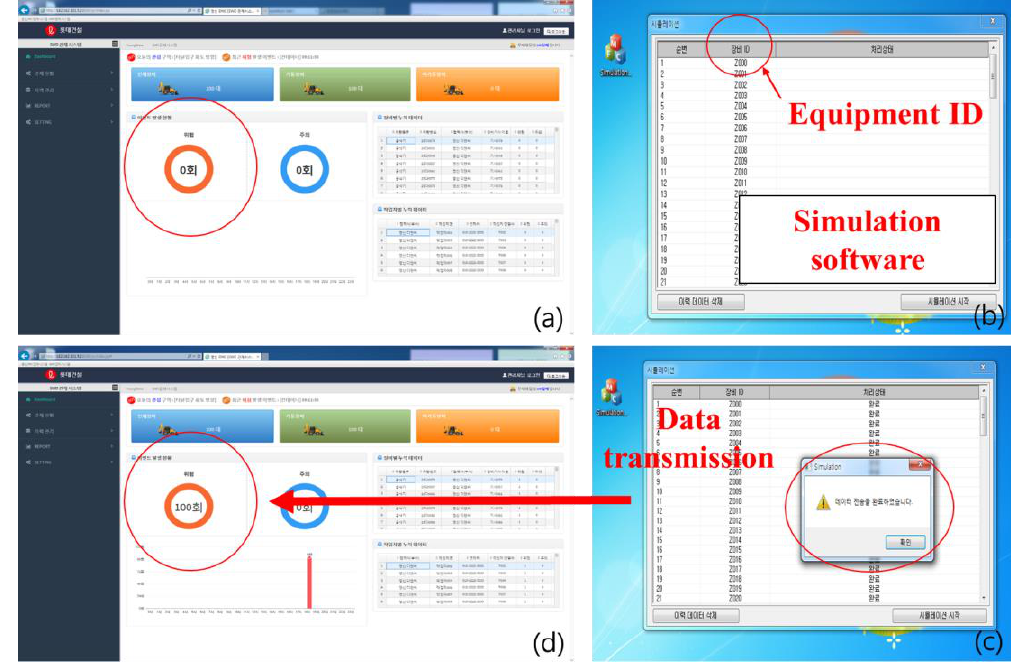
Figure 17. Test result of APS. ( a ) Initial settings, ( b ) equipment ID simulation, ( c ) equipment ID data transmission, ( d ) results in APS.